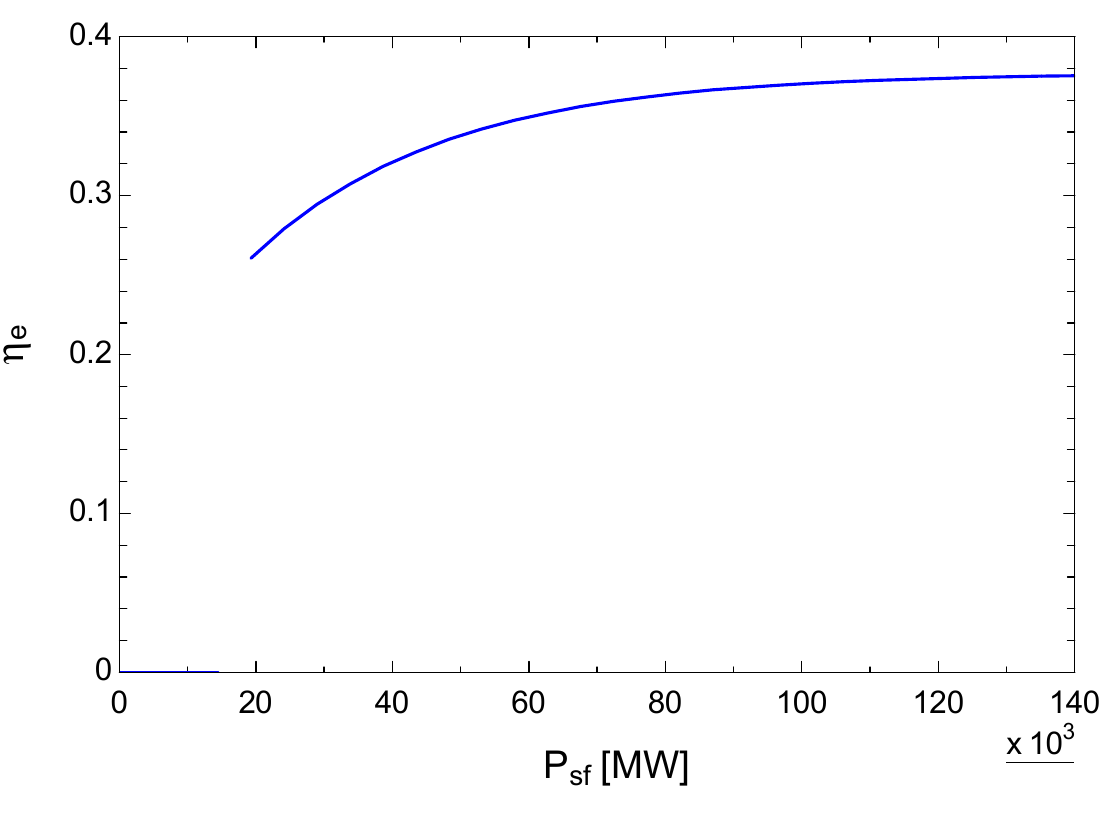
Figure 3. Electric efficiency of the power block as a function of the useful thermal power from the solar field ( P sf ).